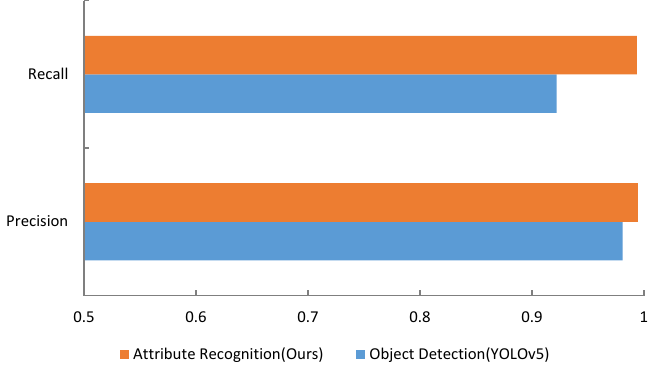
Figure 14. Comparison of recall and precision between attribute recognition model (ours) and object detection model (YOLOv5) under the same